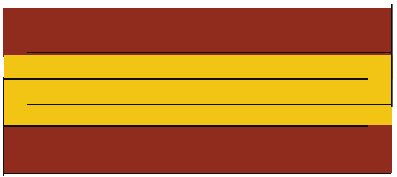
Figure 19: Schematic diagram for NCZF-Stack [0.9 PZT-0.1 PZN]- NCZF trilayer ME